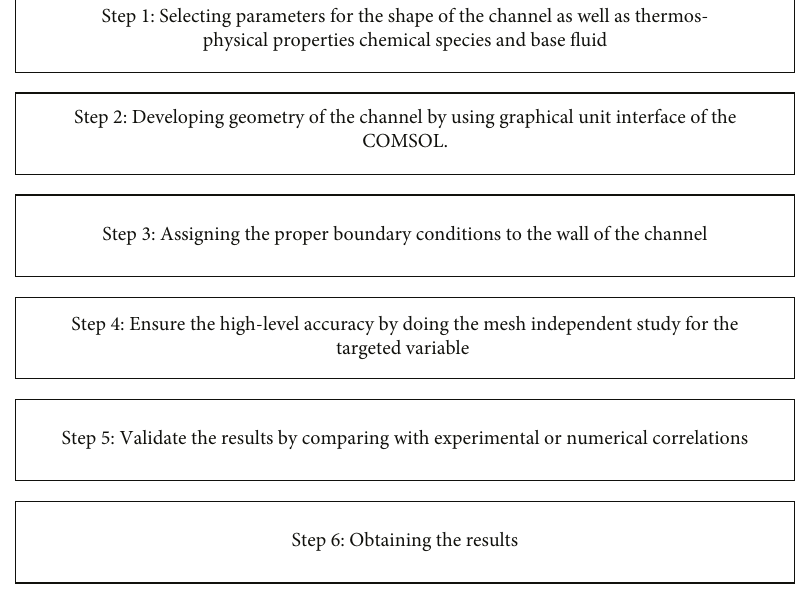
Figure 4: The working wagon wheel of COMSOL Multiphysics